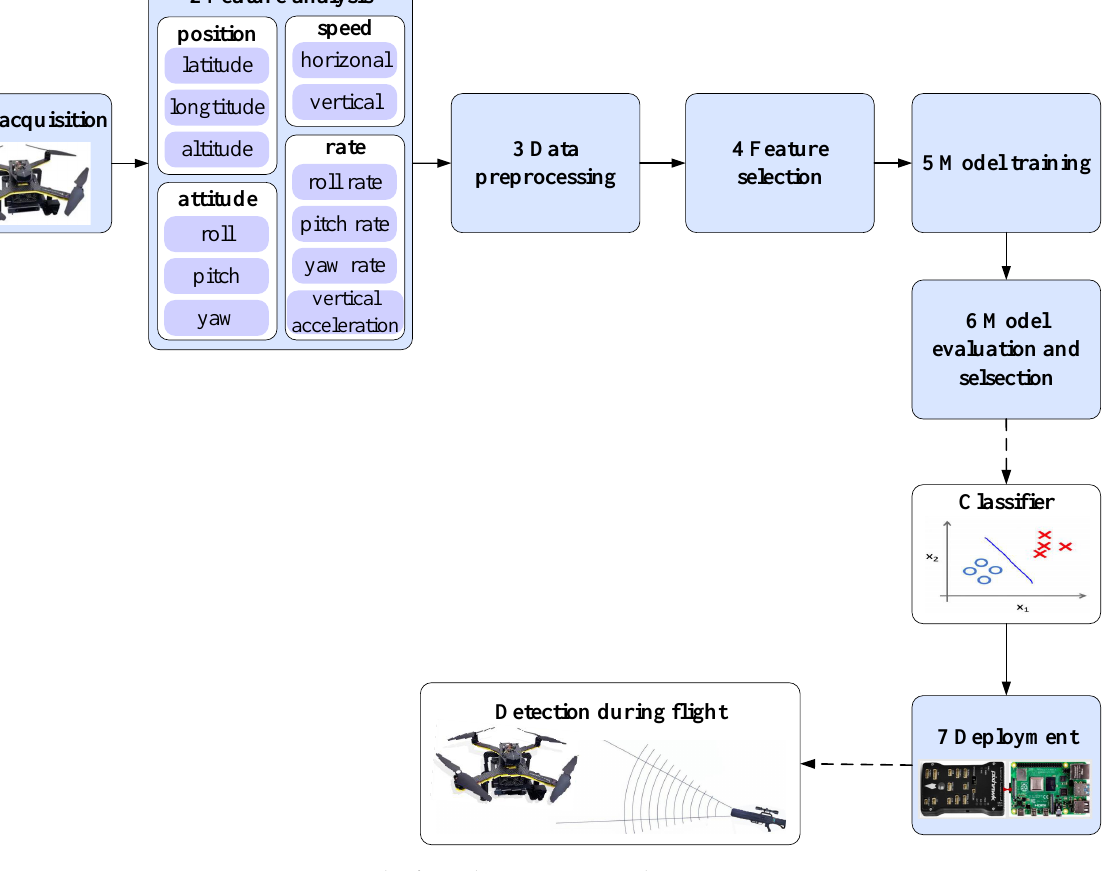
Figure 3. Framework of our detection